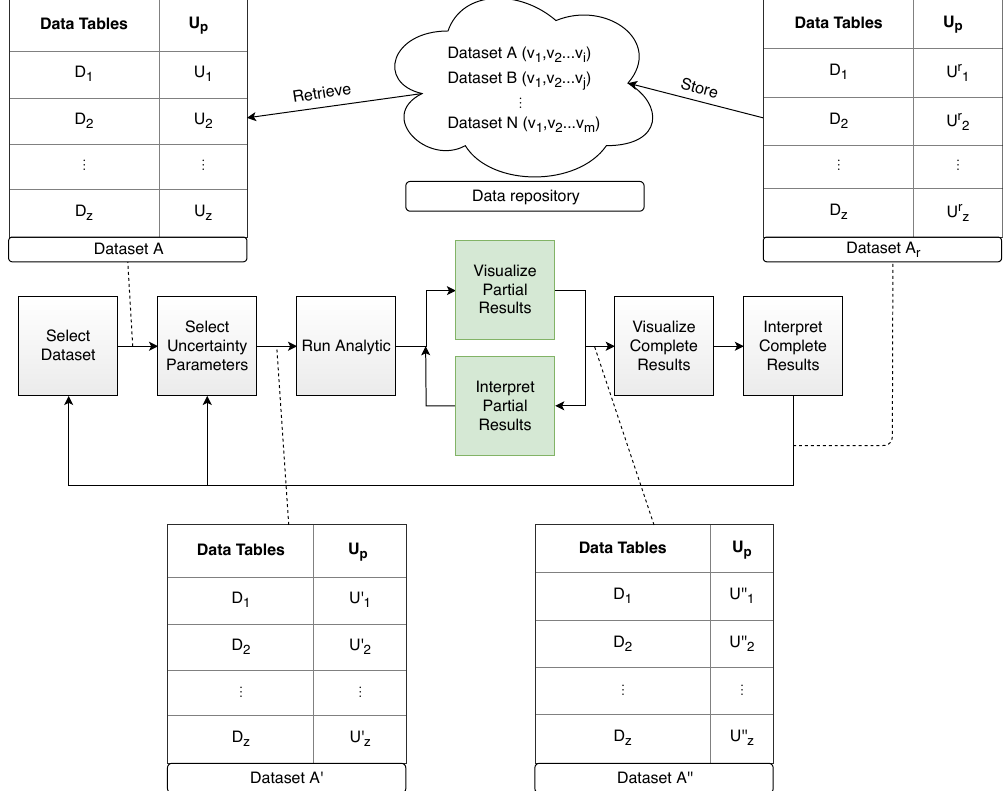
Figure 4. An uncertainty-aware progressive visualization workflow model for the Digital Humanities proposed by the authors and based on the contributions by Stolper [49] and Fekete